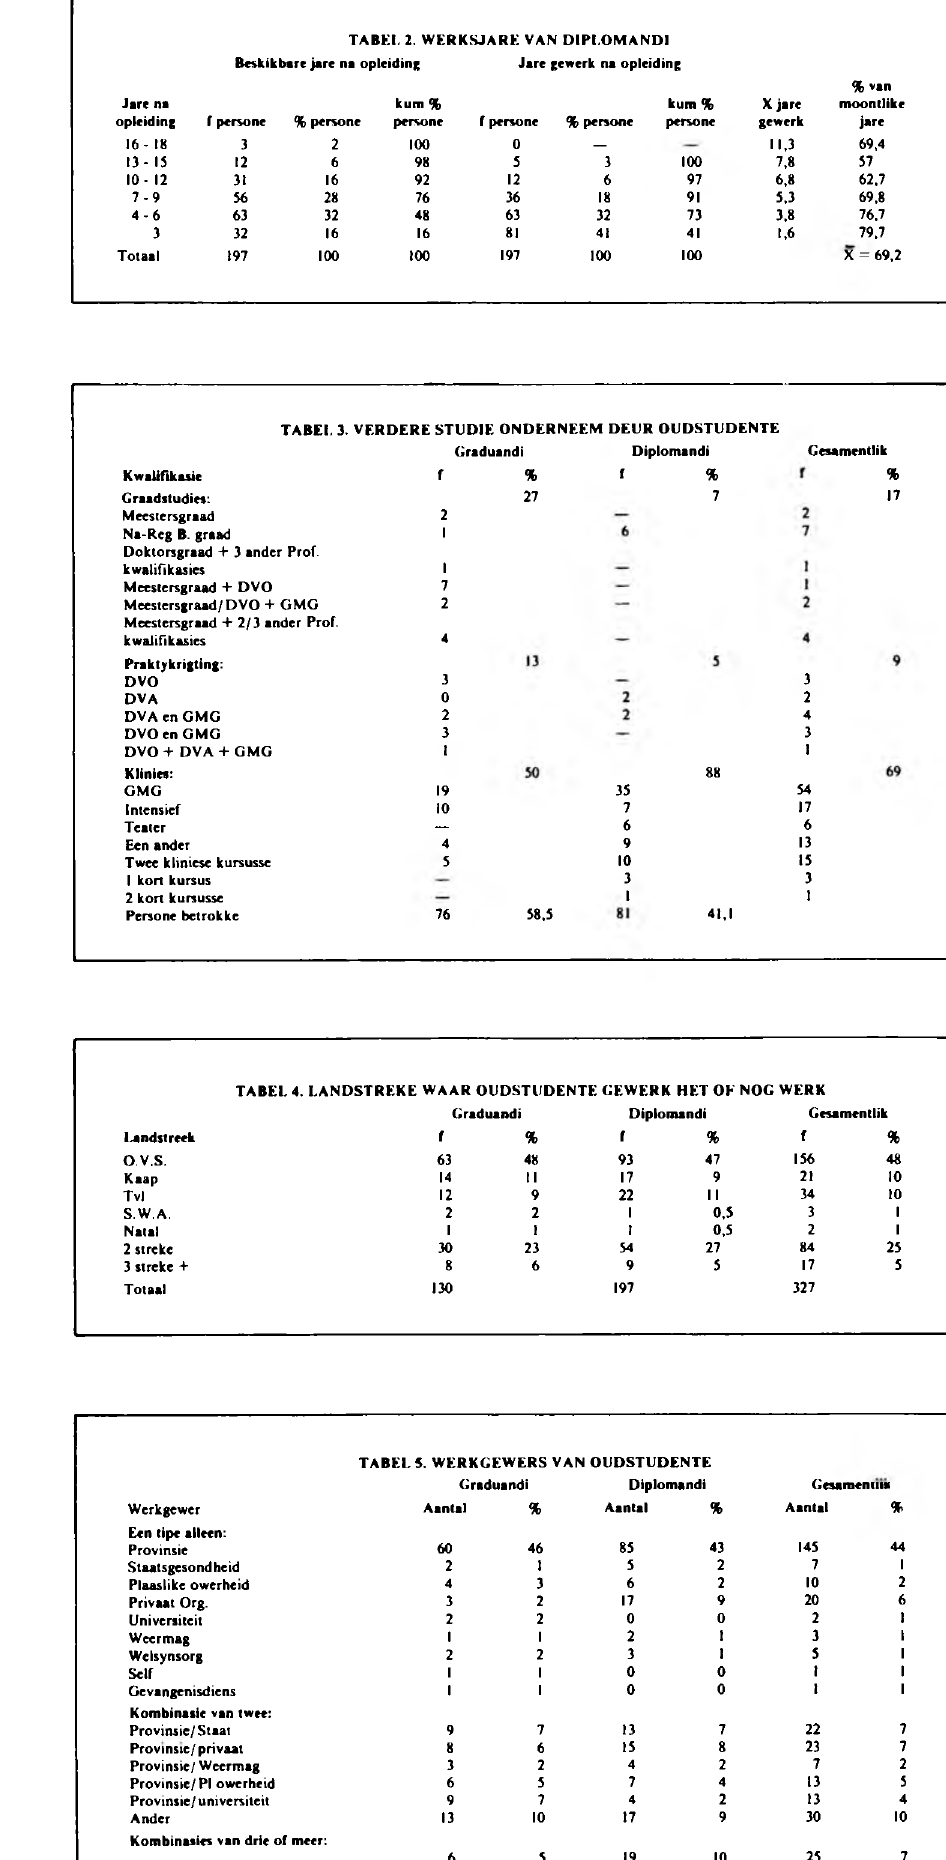
TABKL 2. WERKSJARK VAN DIPLOMANDI Beskikbarc jare na opleidinc Jare sewerk na opleiding